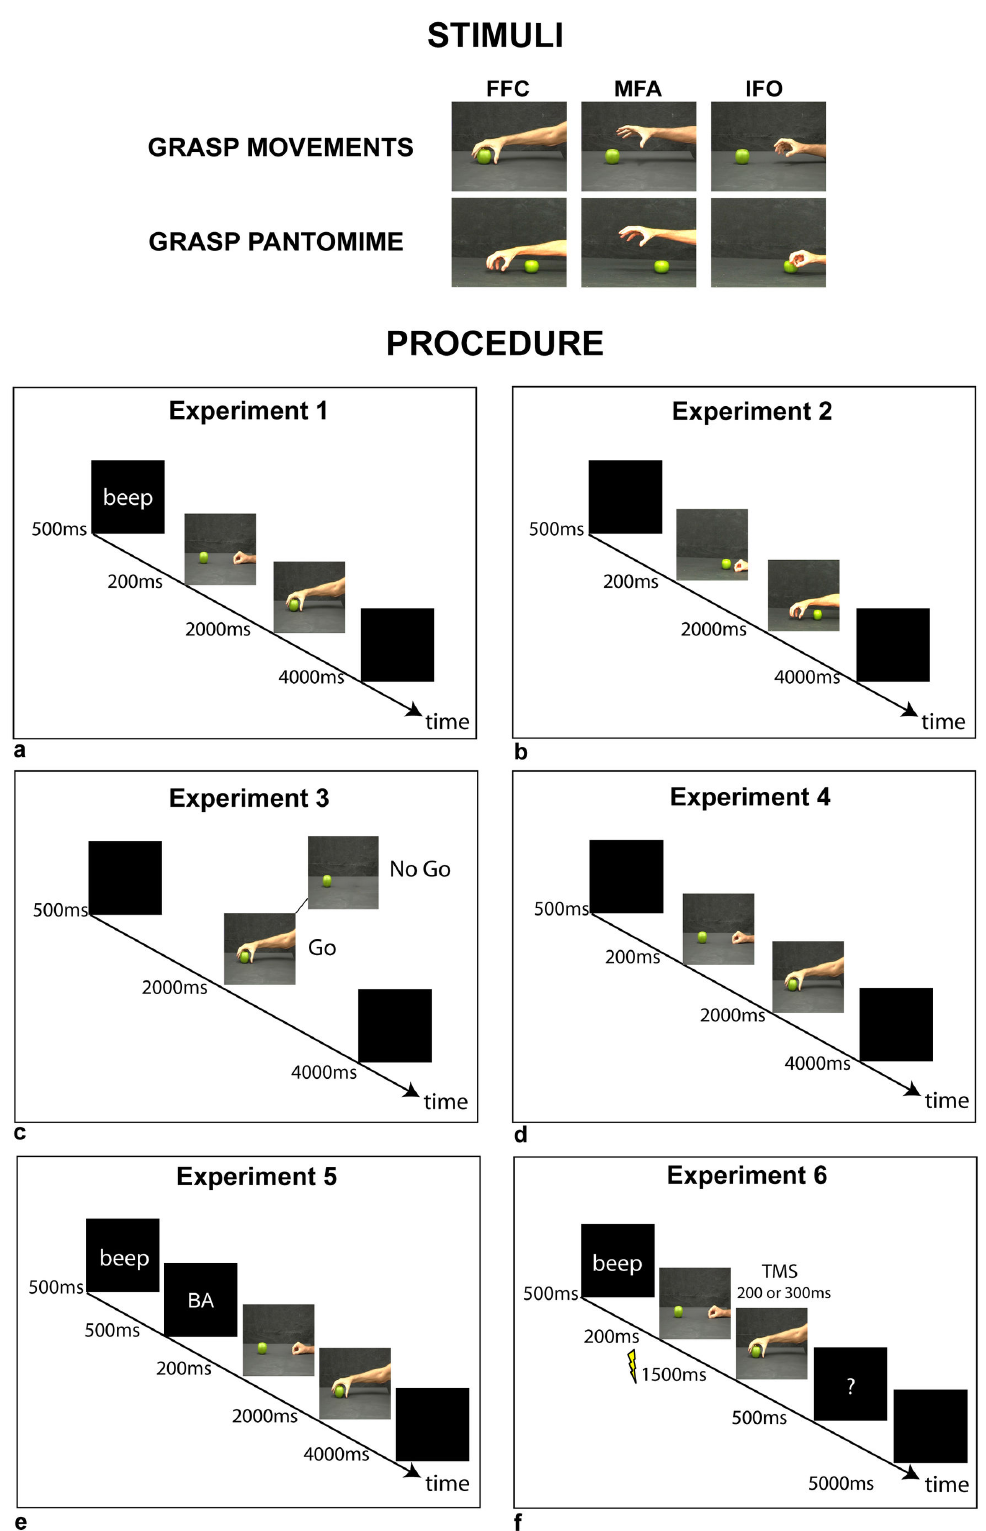
Figure 1. Stimuli and procedure of experiments 1-6. Upper panels show stimuli presented in experiments 1,3,4,5 (first row, grasp movements) and in experiment 2 (second row, grasp pantomime). Lower panels show the procedures of experiments 1-6. doi: 10.1371/journal.pone.0081197.g001 PLOS ONE |